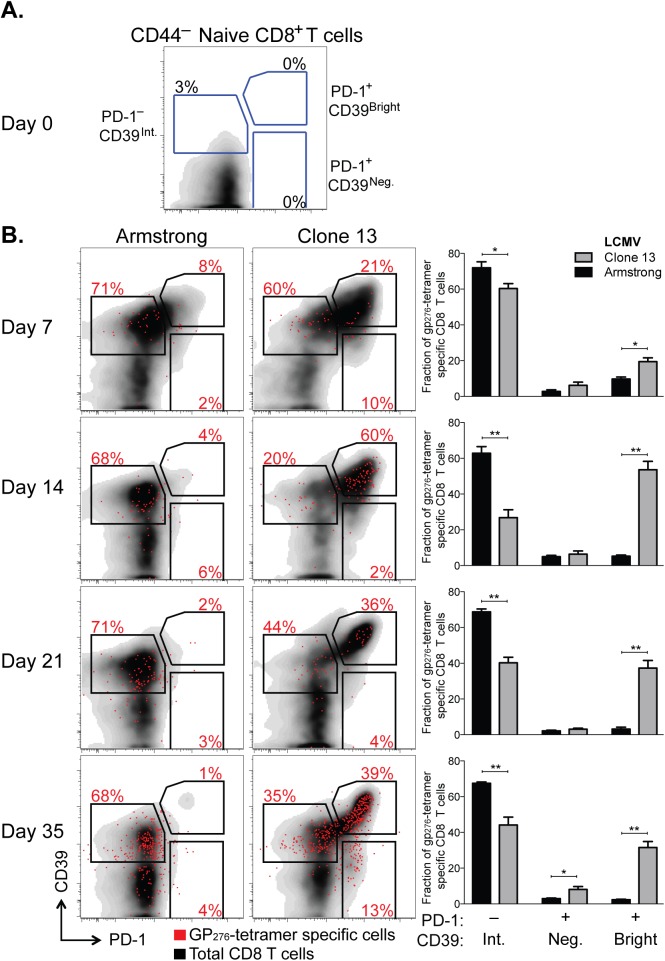
CD39 is highly up-regulated by exhausted CD8+ T cells in a mouse model of chronic infection.(A, B) Expression of CD39 and PD-1 by CD44– naive mouse CD8+ T cells (A) and in CD8+ T cells at indicated times following LCMV Armstrong (acute) or Clone 13 (chronic) infection (B). Representative plots show total (black) and H-2Db GP276-286 tetramer-specific CD8+ T cells (red). Summary of results in 5 mice per group is shown in bar-graphs on the right. Statistical significance was assessed with Mann-Whitney test. *P < 0.5, **P < 0.01.